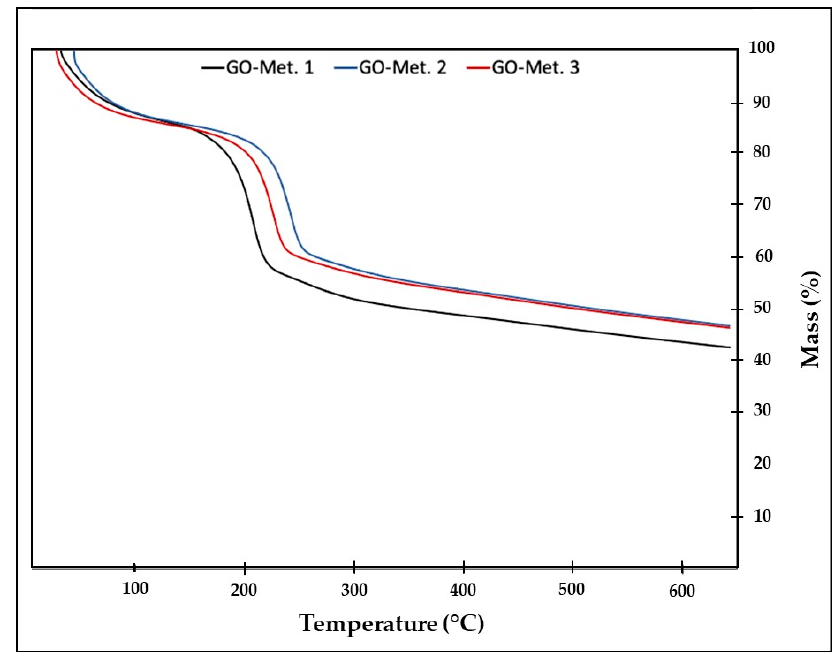
Figure 3. Thermogravimetric analysis curves of analysed GO samples.